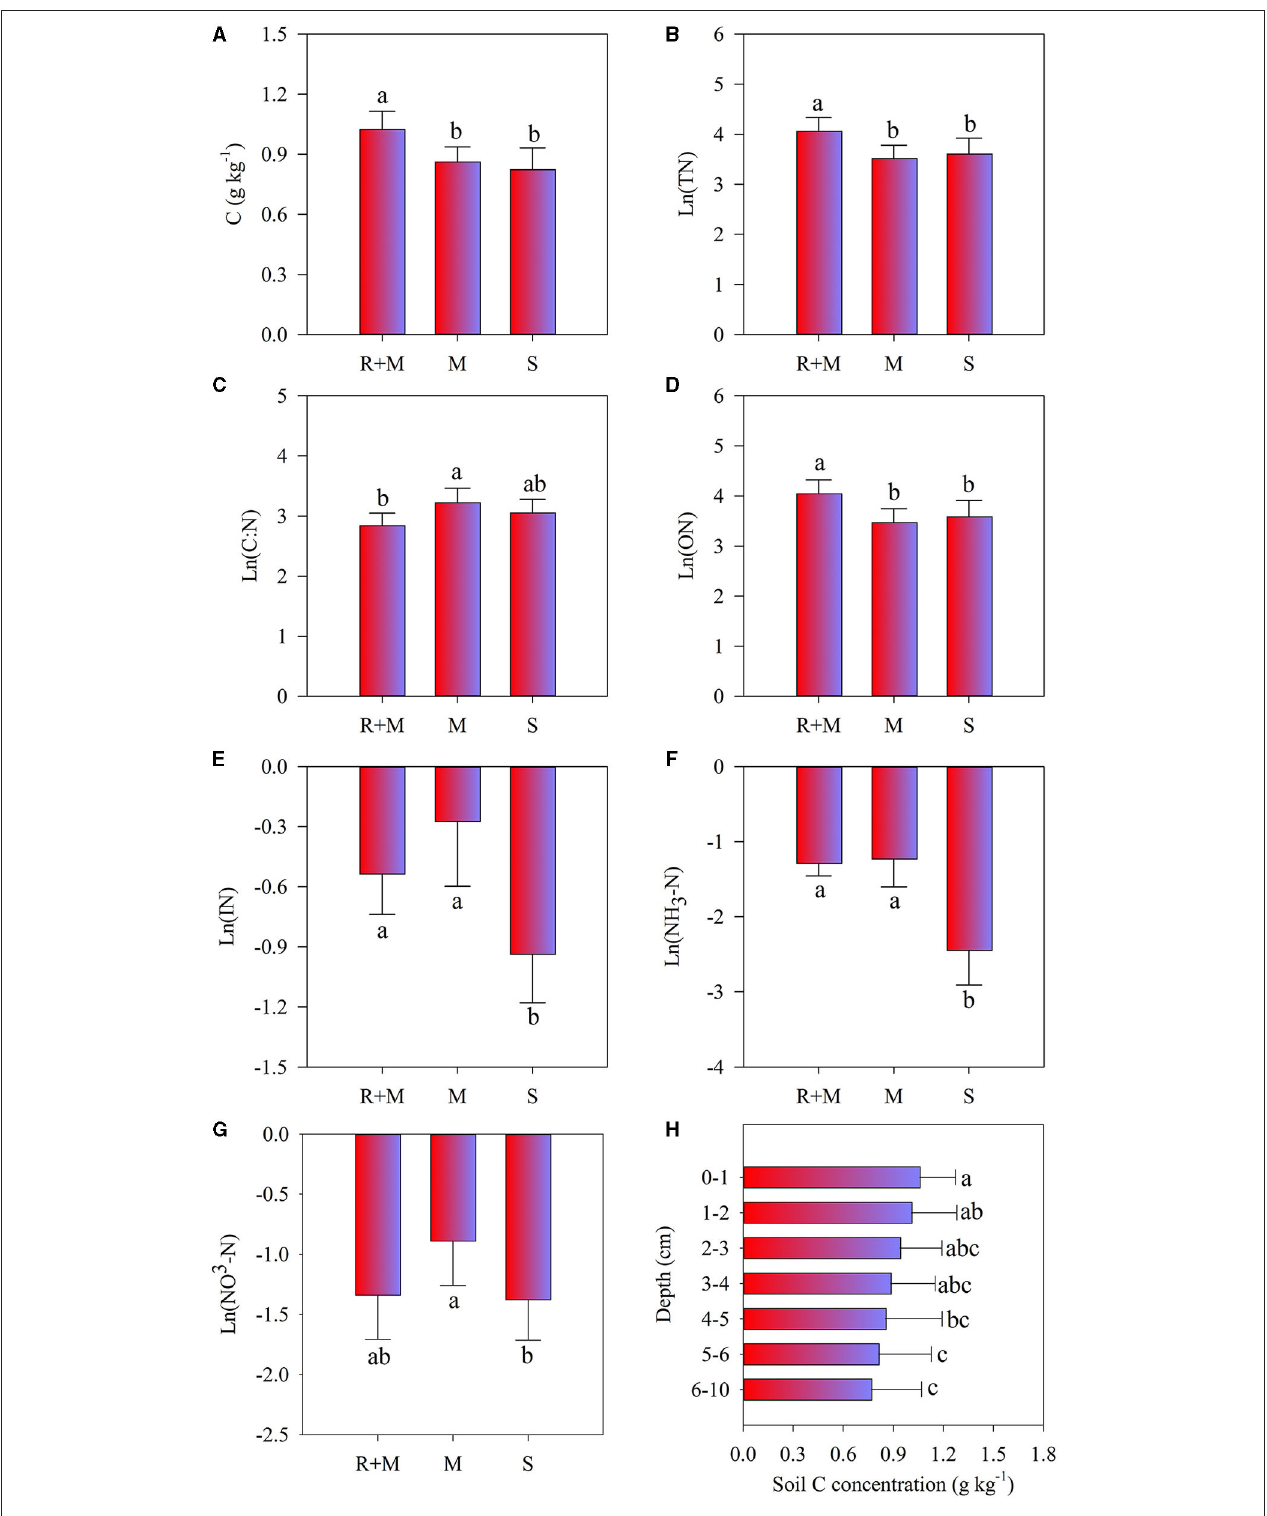
FIGURE 5 | Soil properties of soil C concentration (A) , soil total-N (TN) concentration (B) , soil C:N ratio (C) , soil organic-N (ON) concentration (D) , soil inorganic-N (IN) concentration (E) , ammonium-N (NH4-N) concentration (F) , and nitrate-N (NO3-N) concentration (G) under the litterbag after 1 year of decomposition of the fine roots of A. halodendron . (H) indicates the concentration variation of soil C concentration among soil depths. Values represent M ± SD . Bars labeled with different letters differed significantly among the treatments ( P < 0.05).